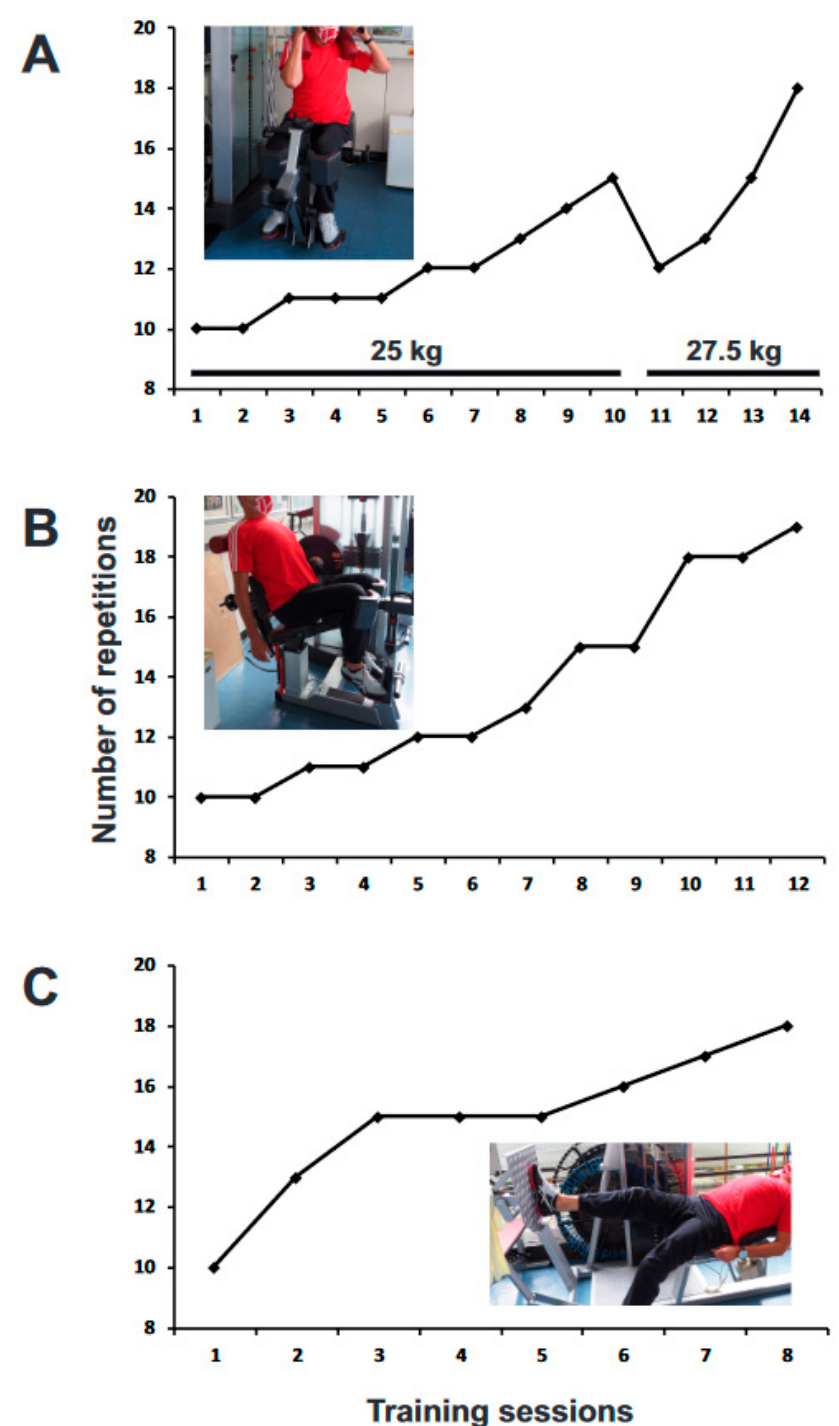
Figure 2. Number of repetitions of different physical exercises without attacks during treatment as a function of training session. Number of repetitions was gradually increased over the course of graded activity. Each physical exercise was performed three times per training session. The average values of the number of 3 different exercises are plotted. Each training session was performed once a week. ( A ) Rotation of the trunk. In the first 10 training sessions, a weight of 25 kg was tolerated without attacks, in the next 4 sessions a weight of 27.5 kg was tolerated. ( B ) Stretching of the trunk against a weight of 25 kg. ( C ) Leg press using only the right leg against a weight of 40 kg.